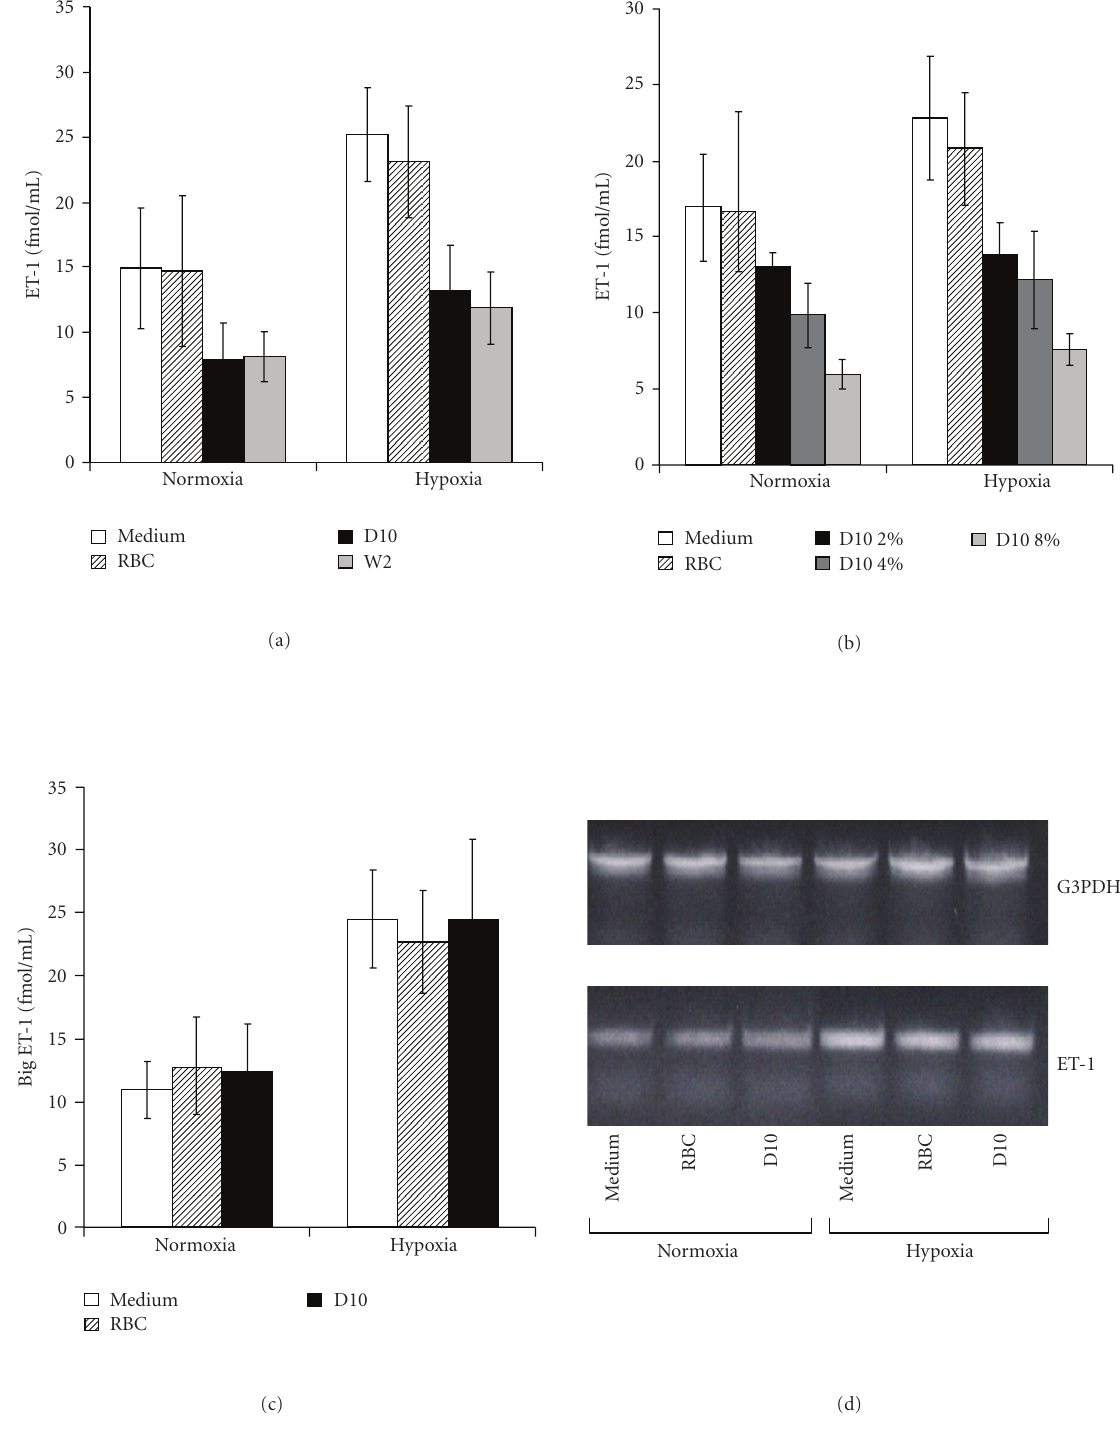
Figure 1: E ff ect of pRBC on the release of ET-1 and big ET-1 from human microvascular endothelial cells (HMECs-1). HMECs-1 were treated for 24 hours in the presence of normal RBC or pRBC (D10 or W2 strains) at 2–4% parasitaemia in (a), (c), (d) or at the indicated levels of parisitaemia (b) under normoxic or hypoxic conditions. Supernatants were then assayed for the presence of ET-1 (a, b) or big ET-1 (c) by ELISA. Results represent the mean ± SD from five di ff erent experiments. (a) P = . 0014 and P = . 0041 D10 versus control in normoxia and hypoxia, respectively; P = . 0017 and P = . 0052 W2 versus control in normoxia and hypoxia, respectively; (b) P = . 014 and P = . 033: D10 8% and 4% versus control, in normoxia; P = . 006, P = . 01, P = . 027: D10 8%, 4%, and 2% versus control in hypoxia. (d) RT-PCR analysis of ET-1. G 3 PDH served as control. The cells were lysed and mRNA extracted. The PCR products were separated through agarose gel electrophoresis and visualized by ethidium bromide. The reported data are representative of three independent